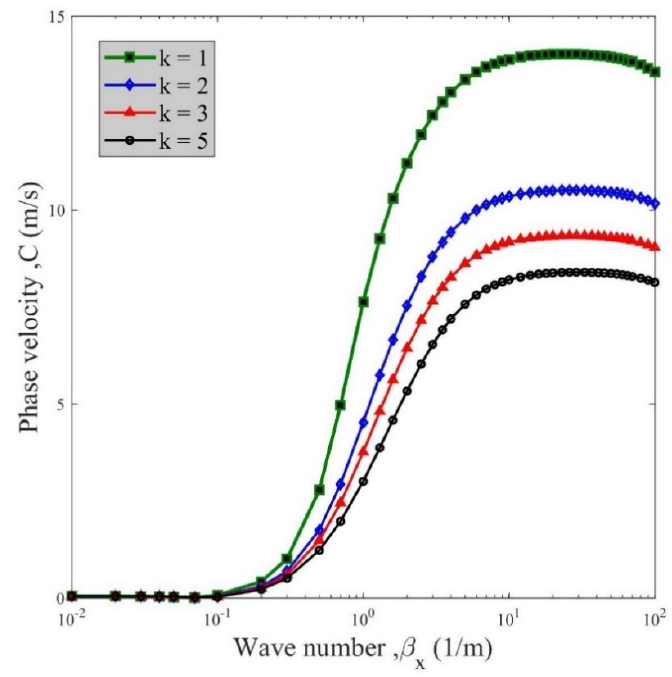
Figure 5. Phase velocity vs. wave number for different values of k .